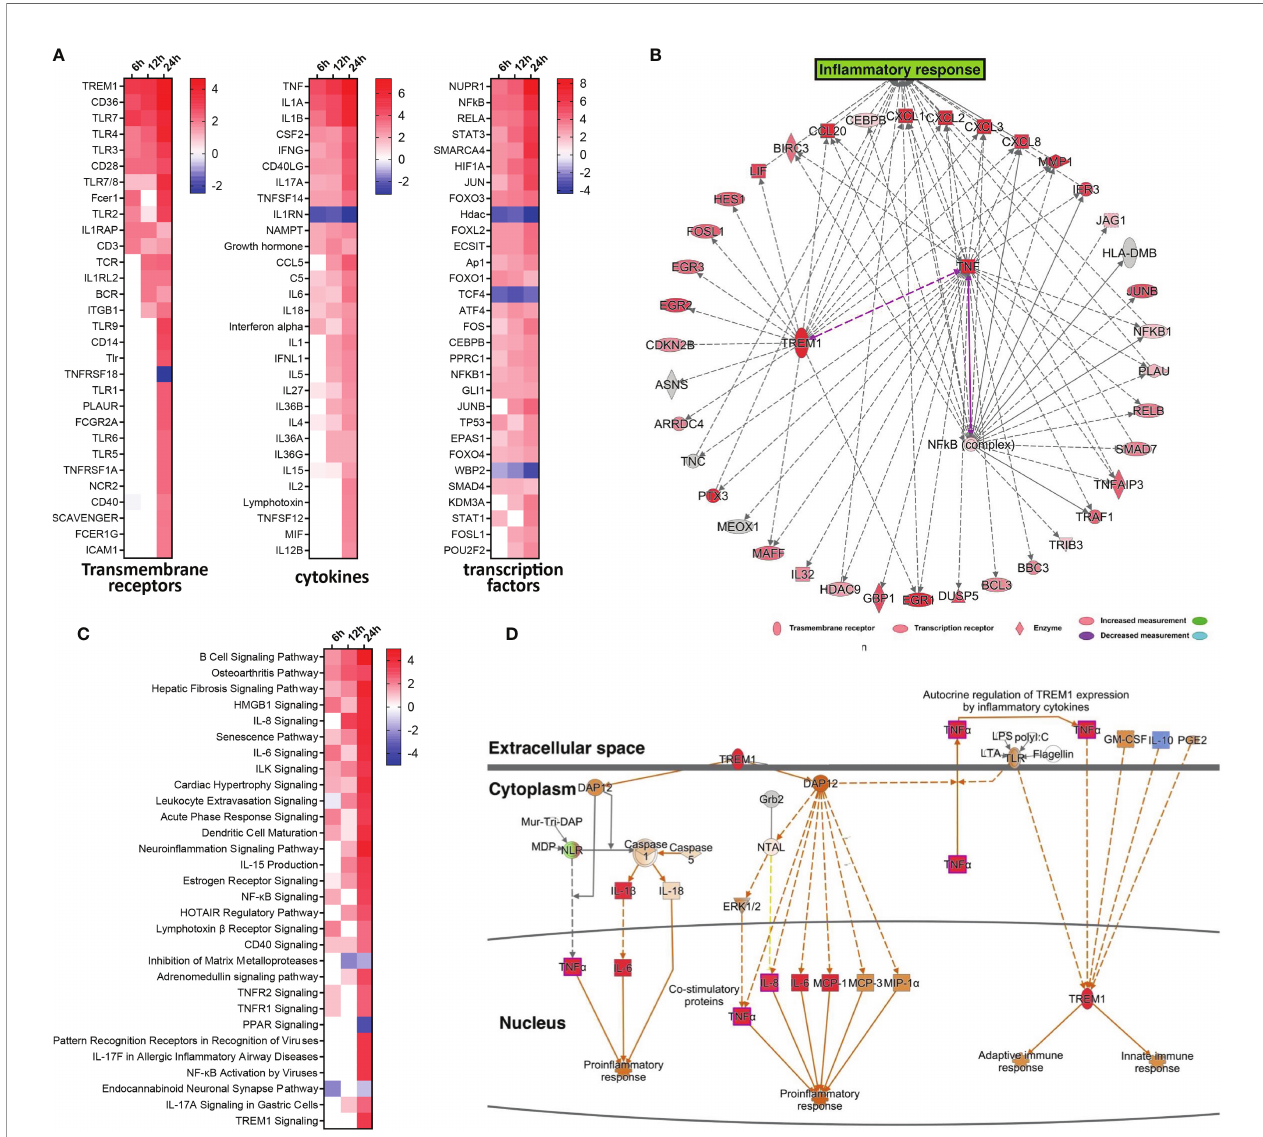
FIGURE 2 | Activated TREM-1 signaling is involved in in fl ammatory responses during EV-D68 infection. (A) The top 30 upstream regulators identi fi ed based on z- score values, including transcription factors, transmembrane receptors and cytokines. Different colors represent the corresponding regulator Z-scores, with activated colored red and inhibited colored blue. (B) GRN at 24 hpi. Target genes of each regulator were used to perform a GRN analysis. Red or pink = upregulated, gray or white = does not meet cut-off criteria or not involved in the pathway. Solid arrows = direct interaction, dotted arrows = indirect interaction. (C) The top 30 enriched signal pathways identi fi ed based on activation z-scores at indicated timepoints. Different colors represent the corresponding signal pathway Z-scores, with activated colored red and inhibited colored blue. (D) The activation level of TREM-1 and downstream in fl ammatory cytokines at 24 hpi were determined by activation z-scores. TREM-1 pathway analysis by IPA. Red or pink = upregulated, green = downregulated), gray or white = does not meet cut-off criteria or not involved in the pathway. Solid arrows = direct interaction, dotted arrows = indirect